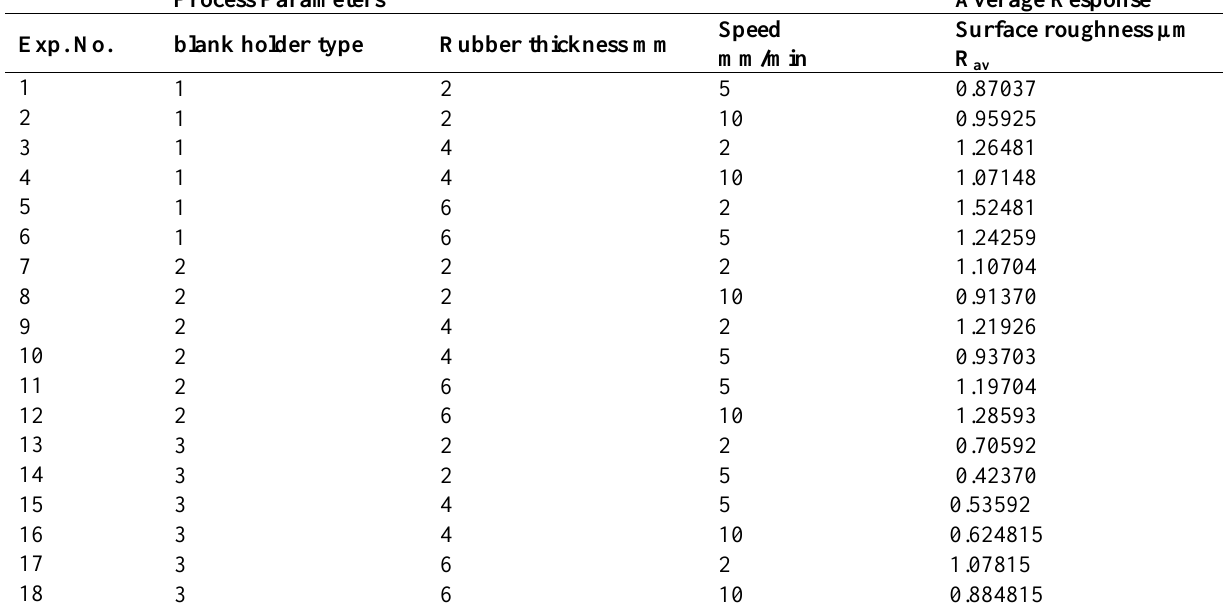
Table 5, prediction of process parameters with respect to response value using empirical equation Process Parameters Average Response Exp.